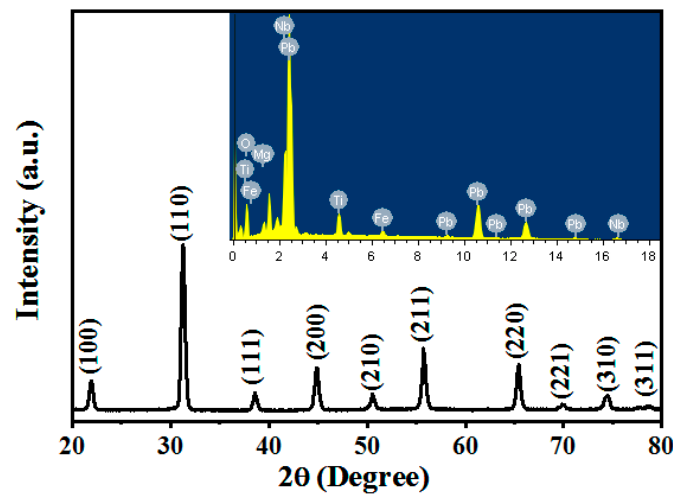
Figure 1. Powder XRD of Fe-substituted PMN-32PT crystal, and Energy Dispersive System (EDS) spectrum (inset).